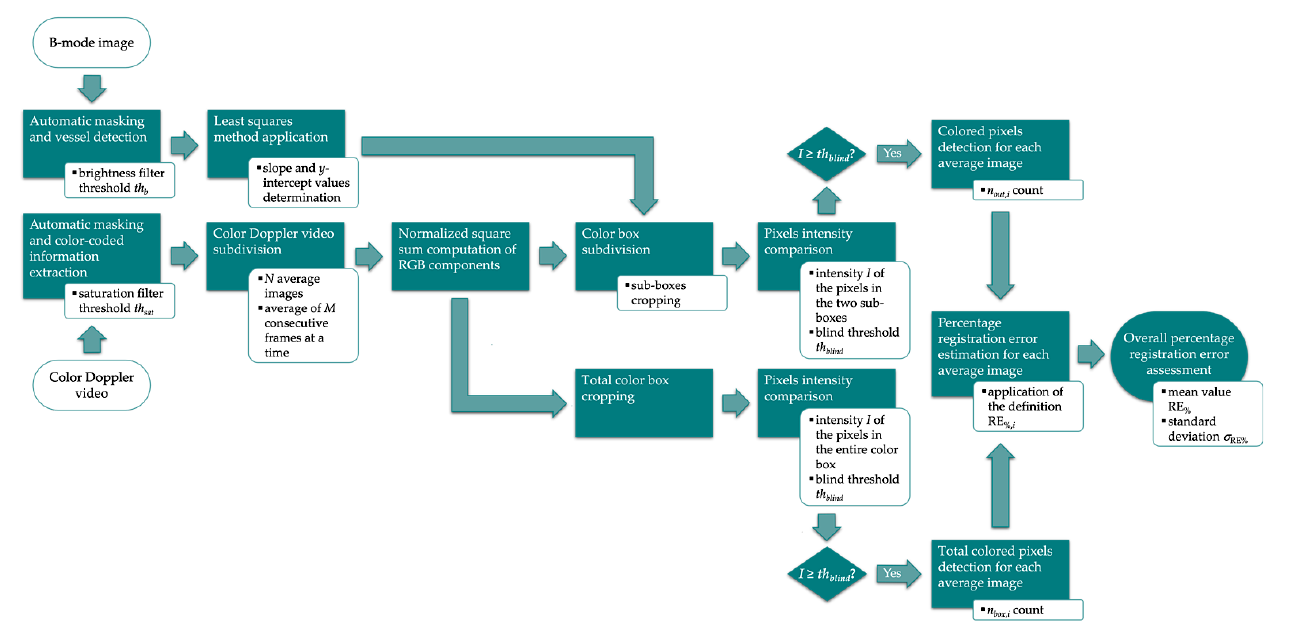
Figure 3. Flow chart of the image analysis-based method for registration error parameter estimation. The US image extraction is applied to the grayscale anatomical image, and an adaptive threshold th b proportional to the mean brightness V (Value in the HSV hexcone model) [45,46] of the US image is automatically determined. This threshold works as a filter for the objective detection of the lumen as well as the boundaries of the phantom vessel. The least squares method is used to determine the slope and y -intercept values of the two straight lines that best approximate the upper and lower